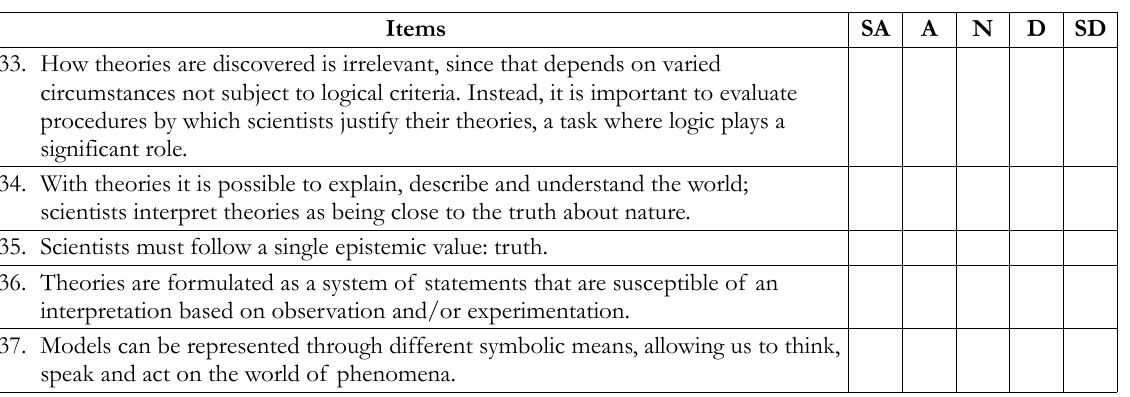
Table 2. Instrument for data collection: Epistemological views on the different topics of the philosophy of